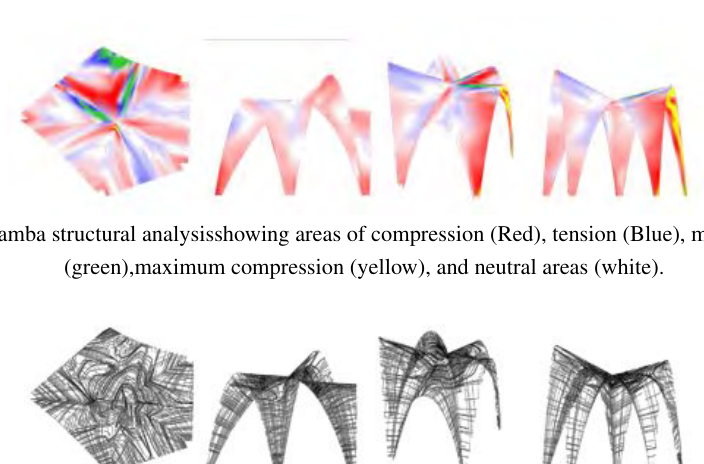
Figure 5. (a) and (b). Analysis of two different mesh subdivisions.